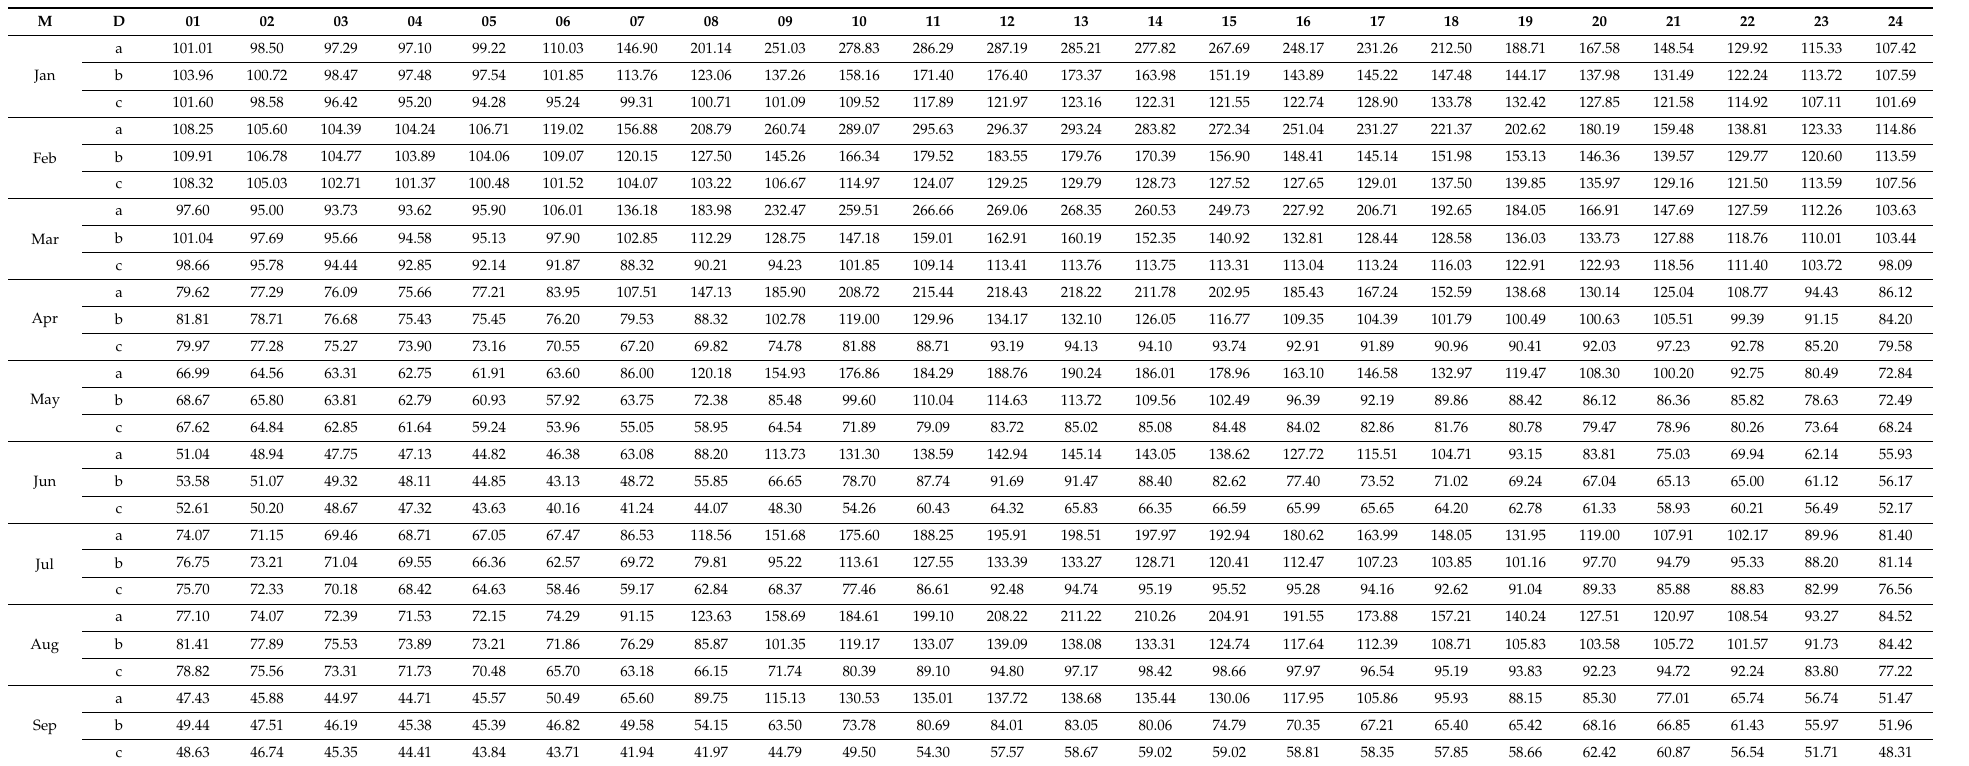
Table A2. Assumed profile in a one-year period with 1-hour resolution, as representative of a B23 consumer: M—month; D—day type; a—working day; b—Saturday; c—Sunday or